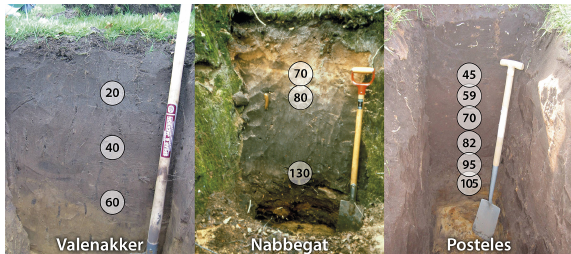
Figure 2. The plaggic Anthrosols Valenakker, Nabbegat and Poste- les. The location of the OSL samples are indicated in the white circles (depth in cm); the locations of the profiles are indicated in Fig. 1.